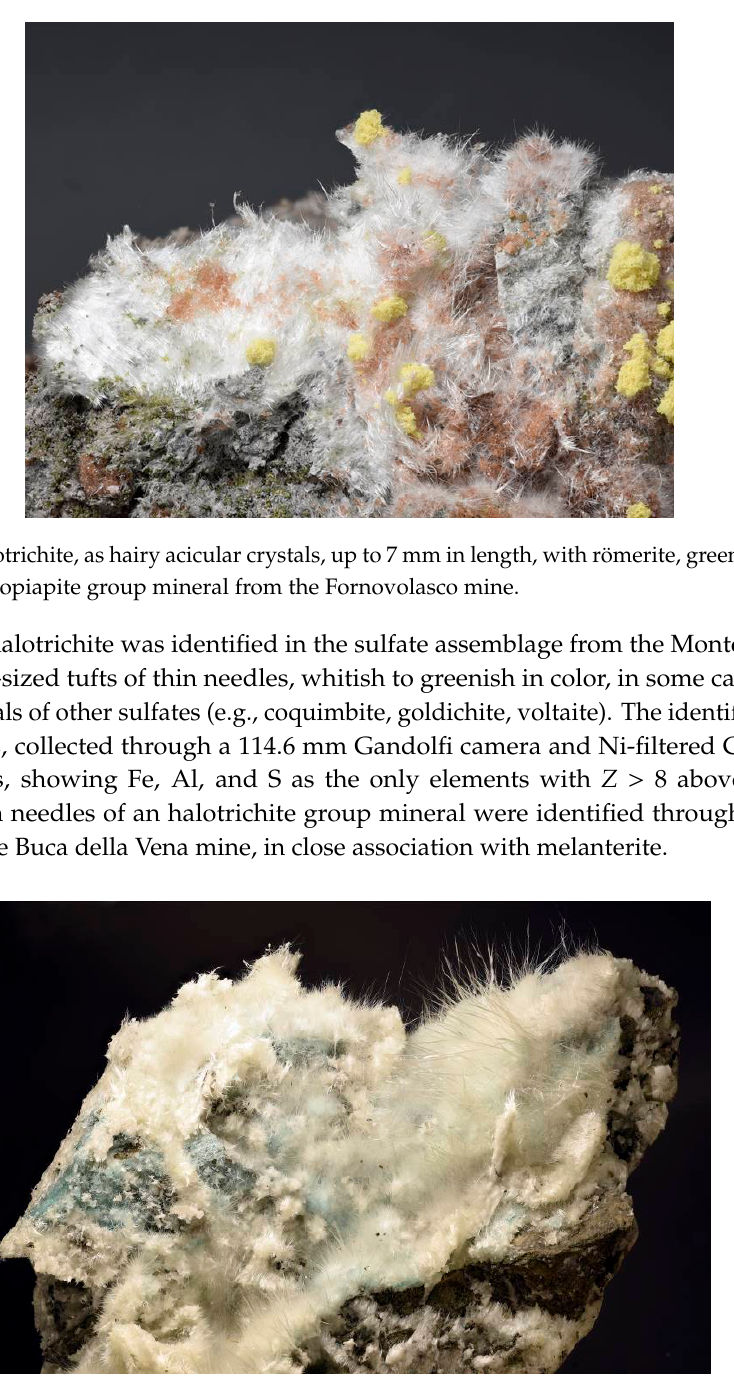
Figure 14. Halotrichite, as hairy acicular crystals, up to 15 mm, from the Monte Arsiccio